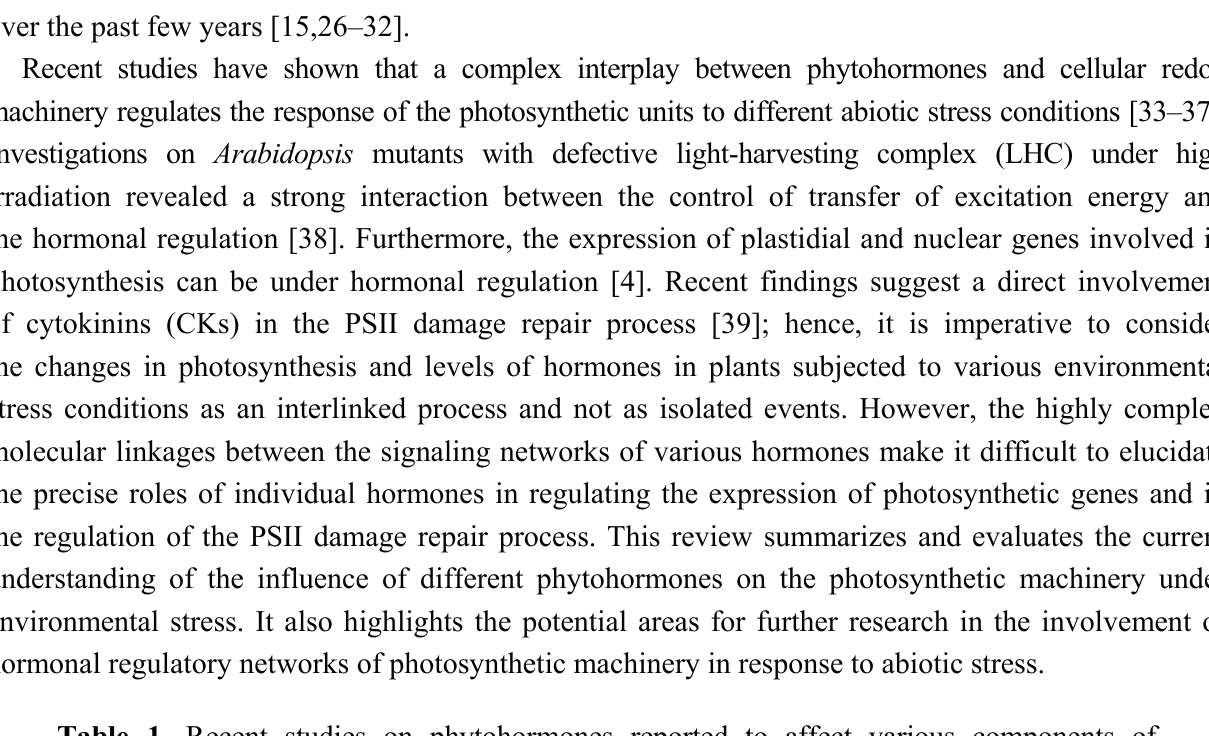
Table 1. Recent studies on phytohormones reported to affect various components of photosynthetic machinery in different plants under abiotic stress